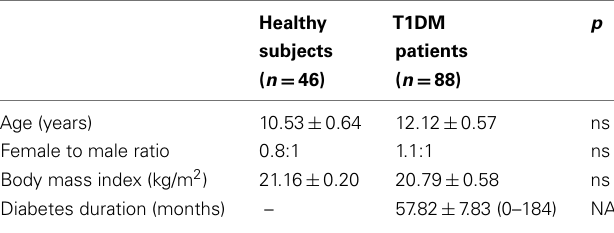
Table 3 | Characteristics of theT1DM patients and healthy subjects.